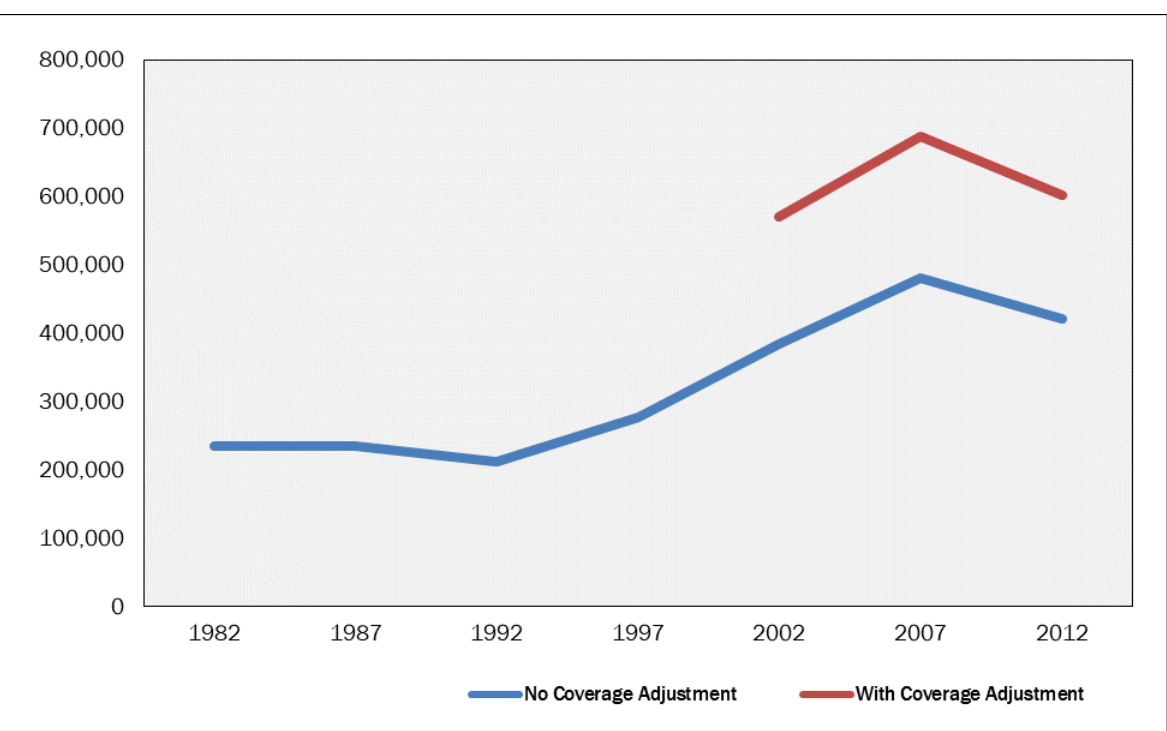
Figure 2. Number of Principal Operators with Sales Below US$1,000,